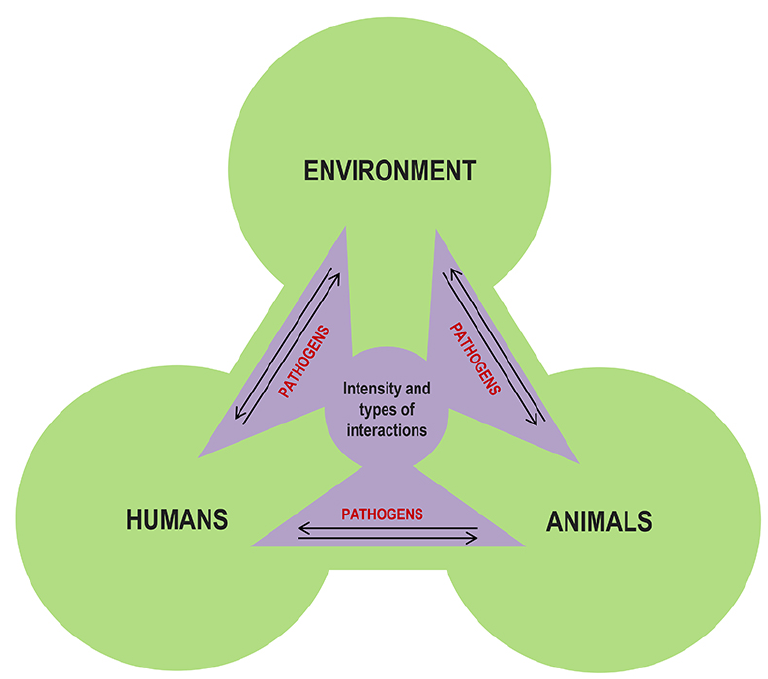
Figure 1 – The One Health perspective. The intensity and types of interactions between humans, animals, and the environment determine the circulation of pathogens between these three actors. Therefore, these interactions can control infectious diseases or facilitate the emergence of outbreaks and epidemics, depending on how humans interact with the environment and other animals. The One Health perspective is used to understand the emergence and spread of infectious diseases and the best ways to control them. Adapted from Ellwanger